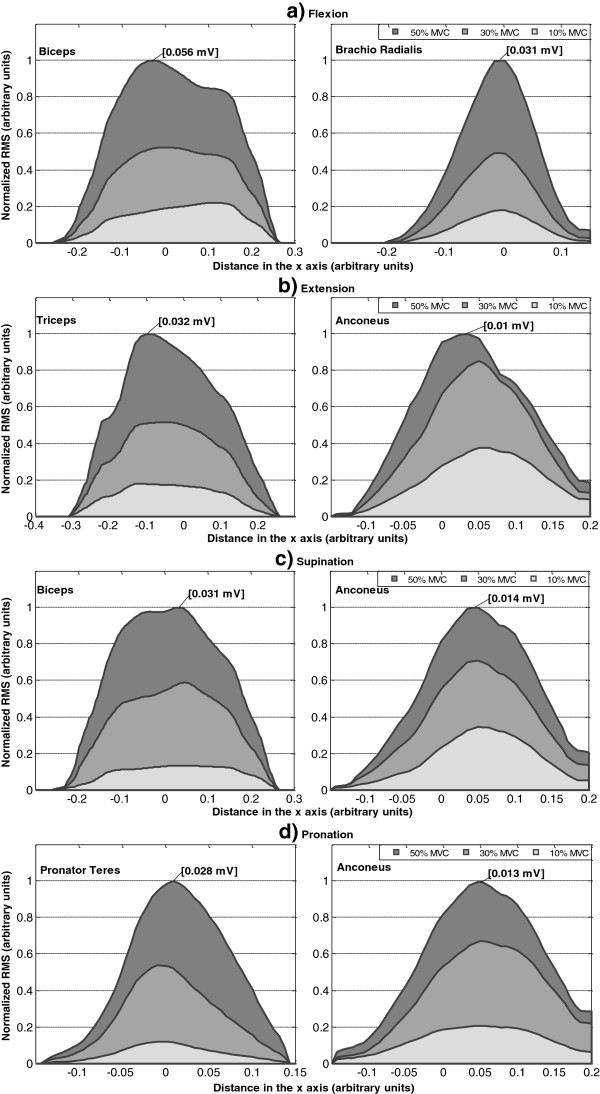
Projections Qkx from the two most active muscles for each kind of task. Curves are normalized with respect to the maximum intensity reached at 50% MVC (showed with a label in each plot). a) Flexion in Biceps and Brachio Radialis, b) Extension in Triceps and Anconeus. c) Supination in Biceps and Anconeus, and d) Pronation in Pronator Teres and Anconeus.